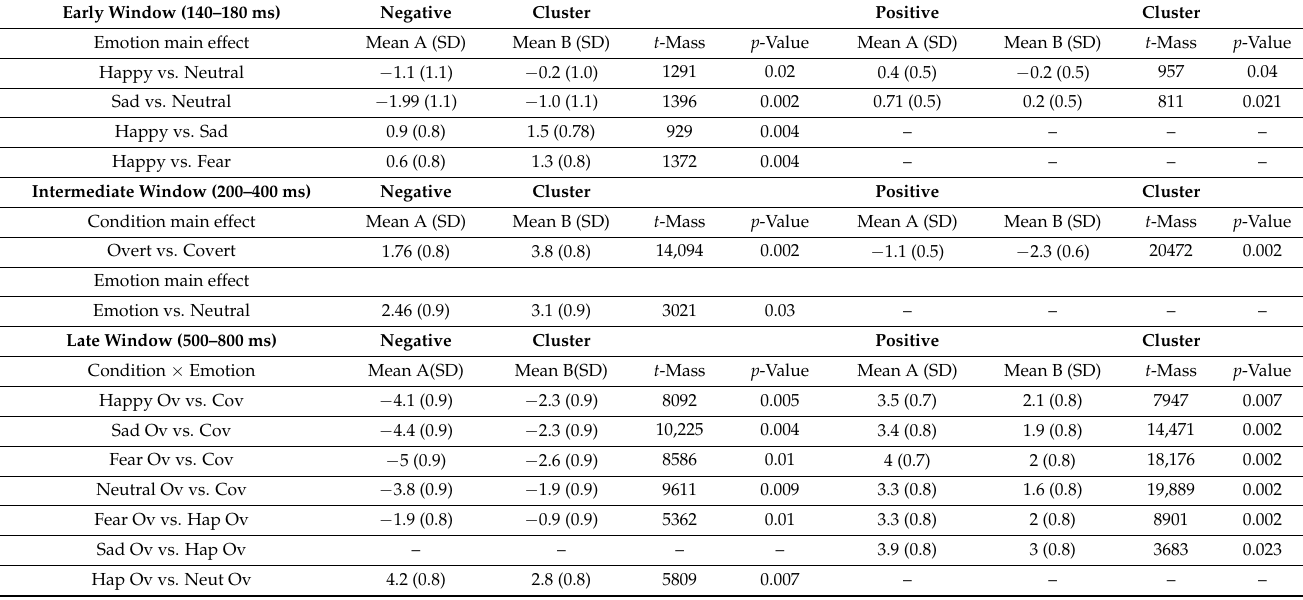
Top: Early time window (140–180 ms), main effect of Emotion. Center: Intermediate time window (200–400 ms), main effects of Condition (above) and Emotion (below). Bottom: Late time window (500–800 ms), Condition X Emotion interaction. In the columns, for each cluster, Mean amplitude and Standard Deviation (SD) for the first (A) and the second member (B), cluster size, and p